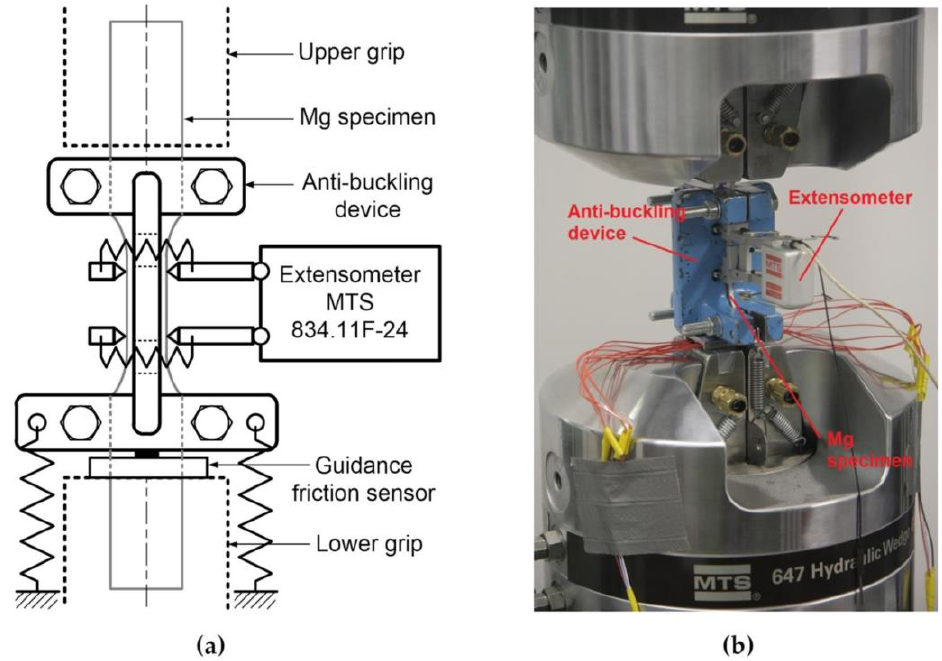
Figure 3. Experimental arrangement for the low-cycle fatigue experiments: (a) schematic representation of the anti-buckling device; (b) real experiment.